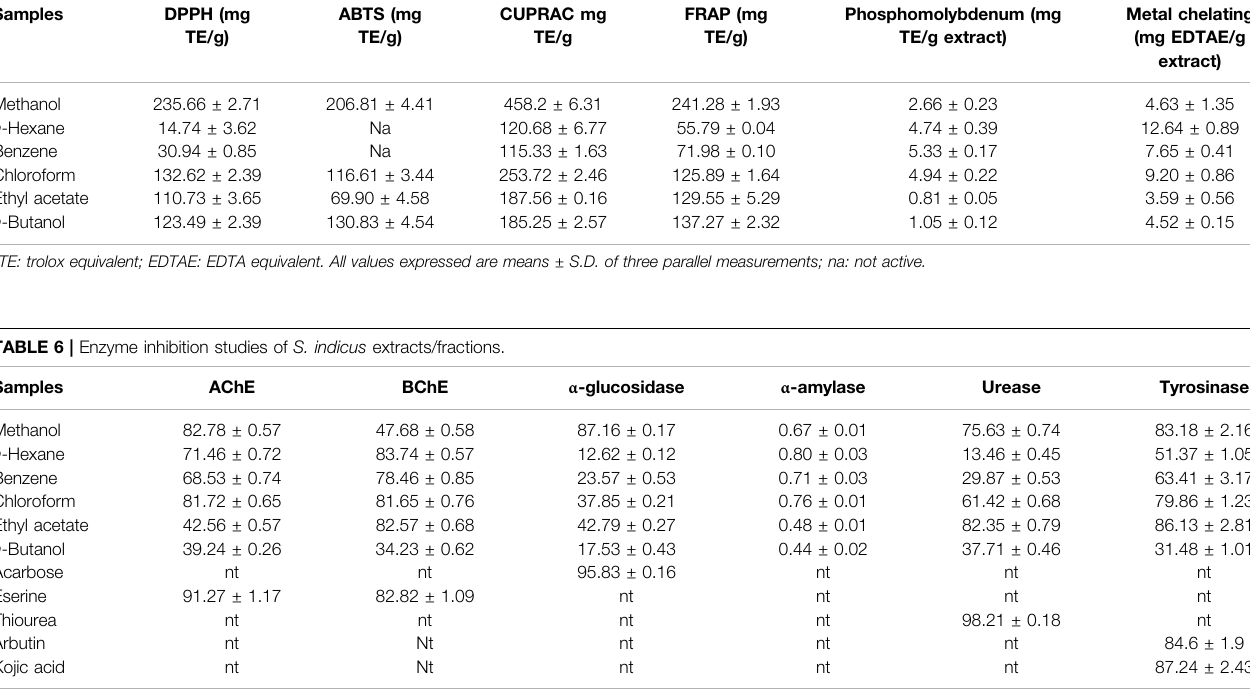
TABLE 5 | Antioxidant activities of S. indicus extracts/fractions. Samples